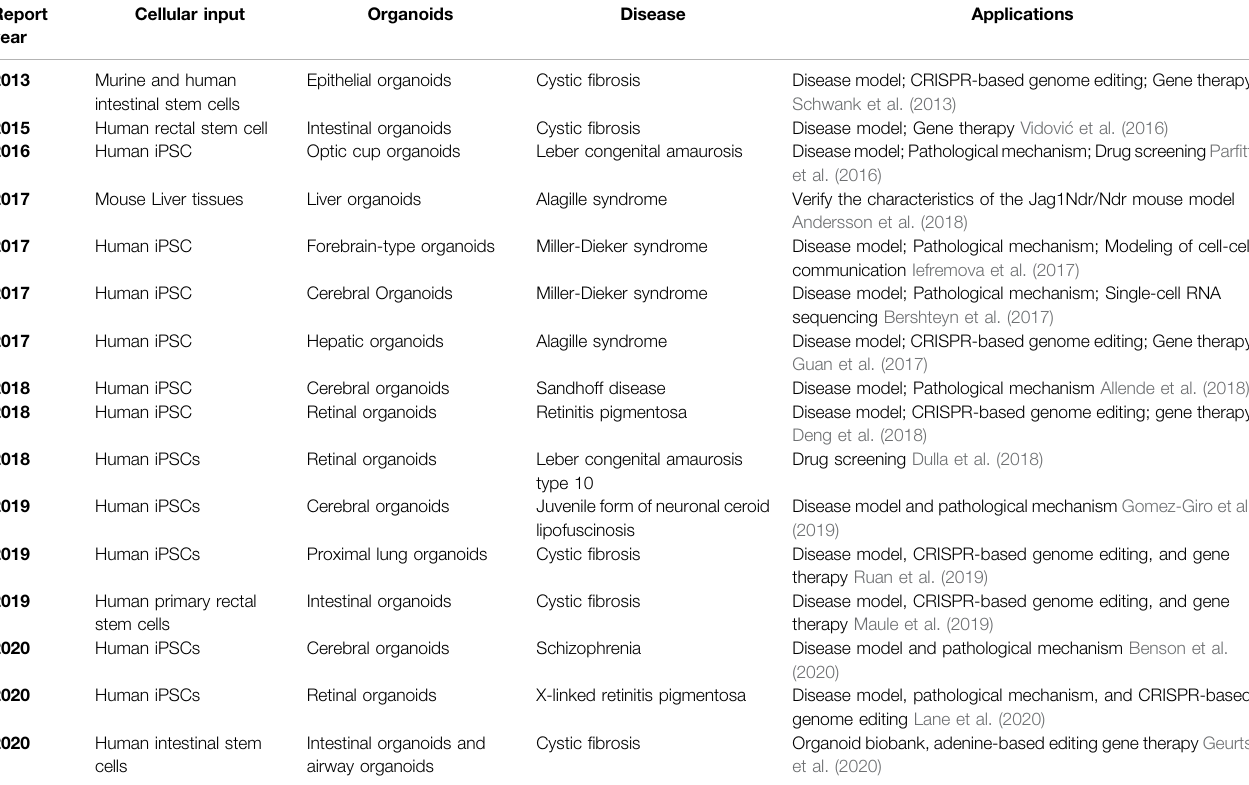
TABLE 2 | Unique advantages of organoids in hereditary